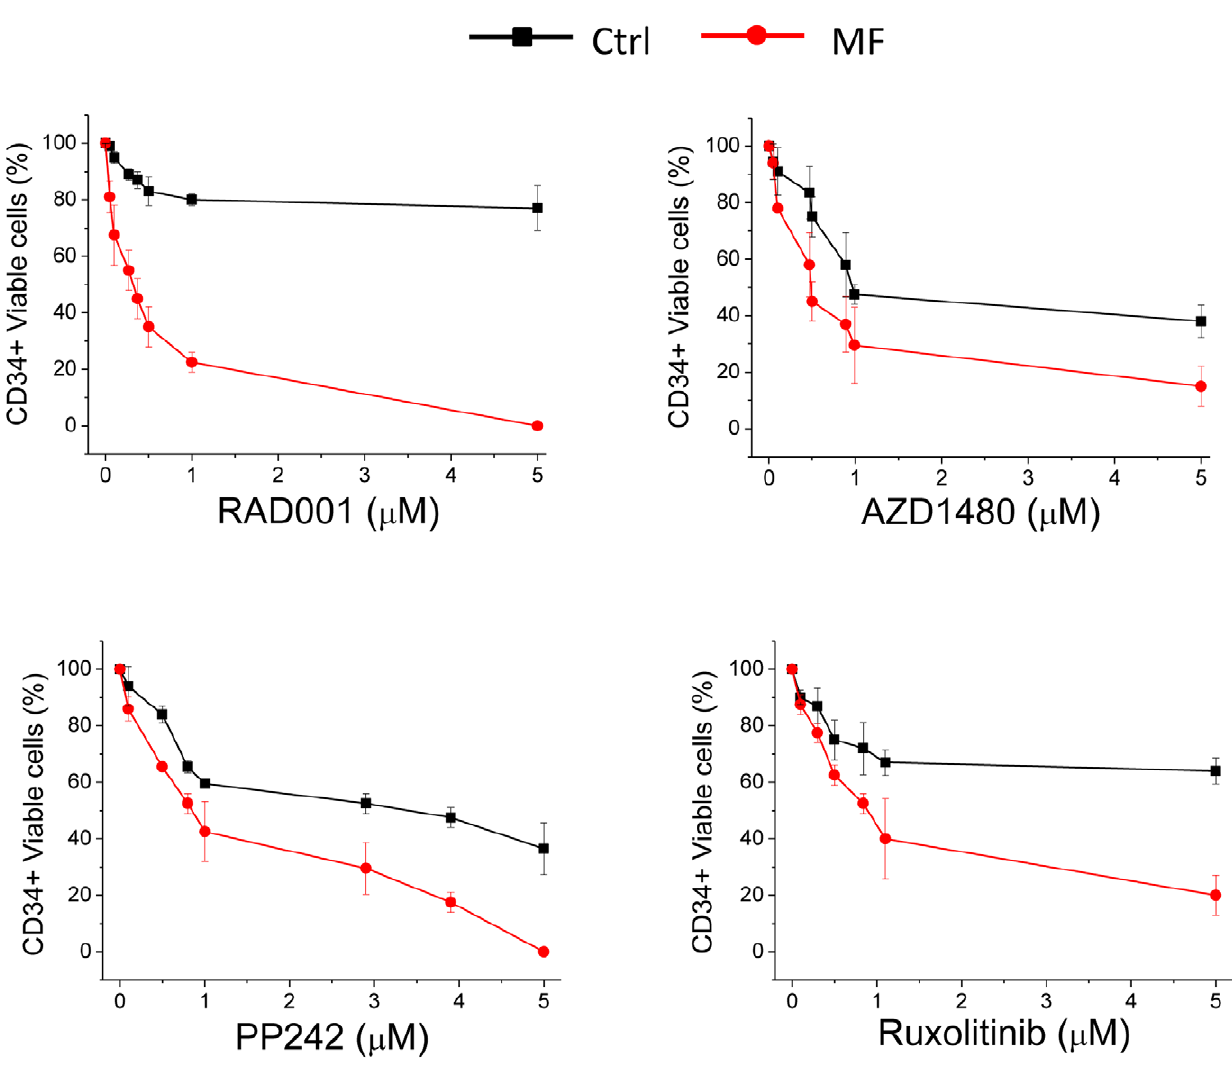
Figure 2. Inhibition of proliferation of CD34 + cells from PMF patients by mTOR and JAK2 inhibitors. CD34 + cells from patients with PMF (n=6) or control subjects (Ctr; n=5) were plated at 2 6 10 5 /mL in 96-well culture tissue plates with increasing concentrations of the drugs, in triplicate; viable cells were assessed after 48 hrs using the WST-1 assay and normalized to wells containing an equivalent volume of vehicle (DMSO) only. Values shown are the mean 6 SD The concentration at which 50% inhibition of proliferation occurred (IC 50 ) was calculated (see Results section for